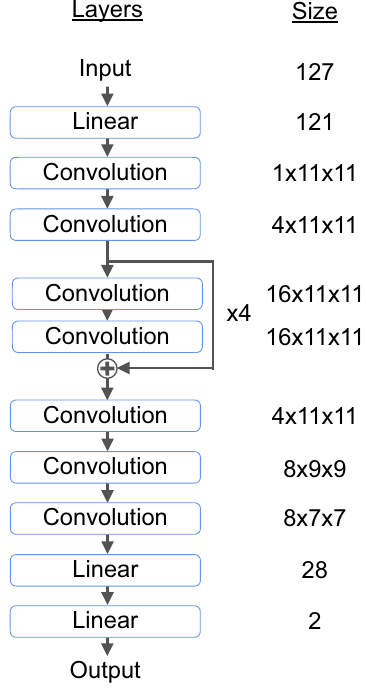
Fig. 5 Schematic view of the chosen network architecture